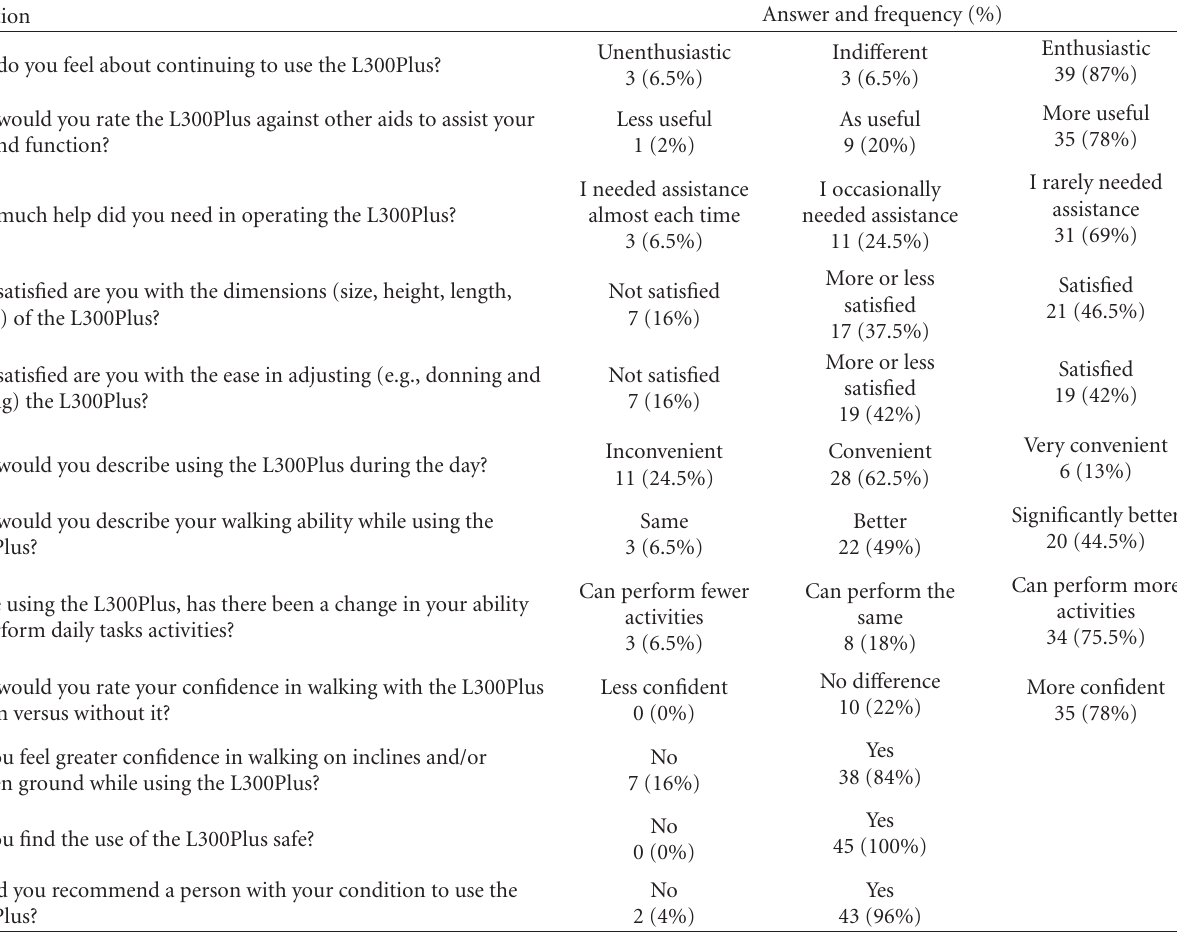
Table 3: Summary of the subject’s acceptance